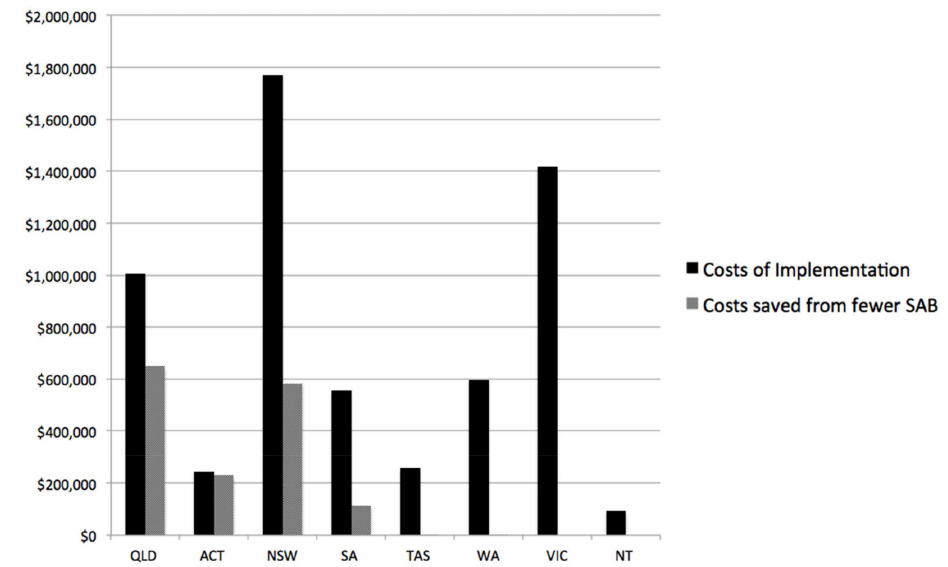
Fig 2. Cost increases and cost savings by state and territory for the National Hand Hygiene